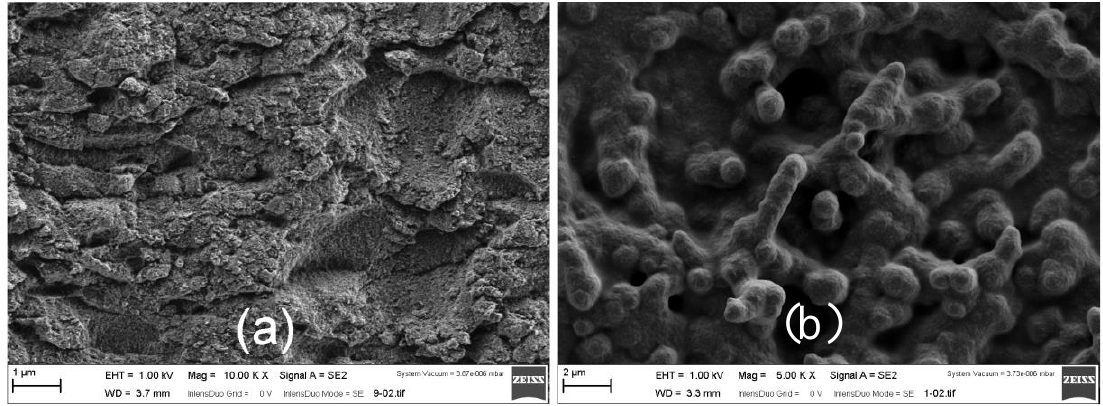
Figure 6. Scanning electron microscopy (SEM) images of GC-modified electrodes: ( a ) SWCNT@SiO 2 ; ( b )SWCNT@SiO 2